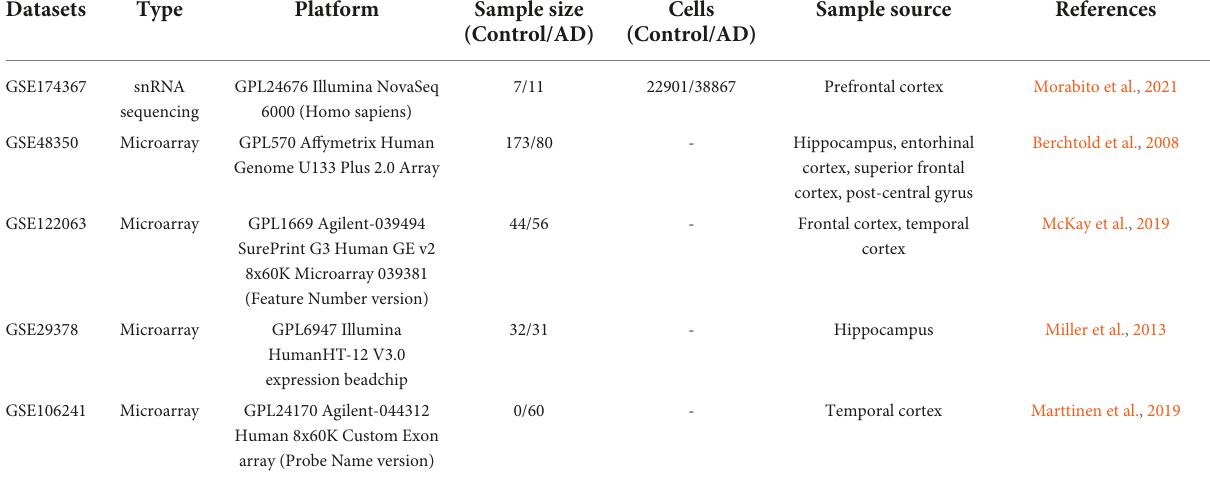
TABLE 1 The enrolled datasets in the